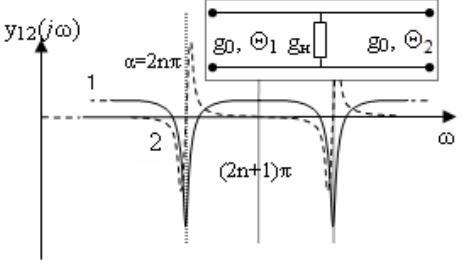
Fig. 2. Resonance properties of the coupling conductivity; 1 – Re y 12 , 2 – Im y 12